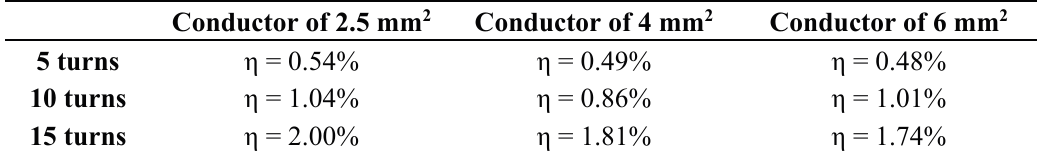
Table 2. Air-core transformer efficiency.